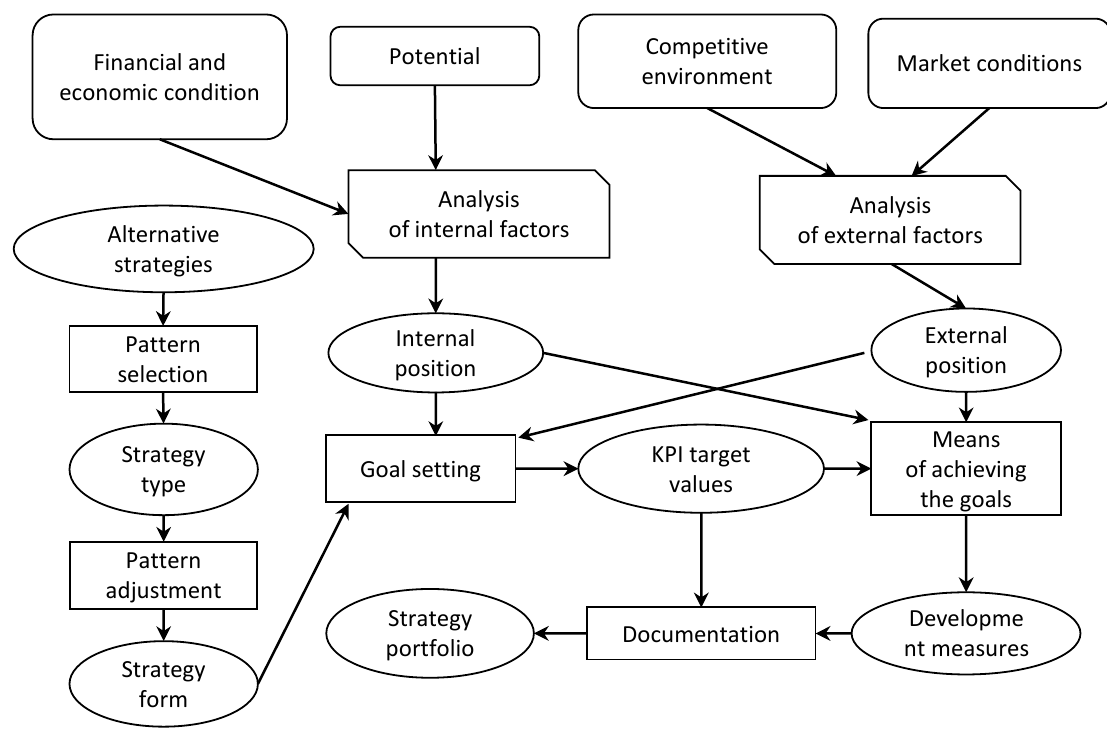
Figure 1. Technological network of enterprise strategy